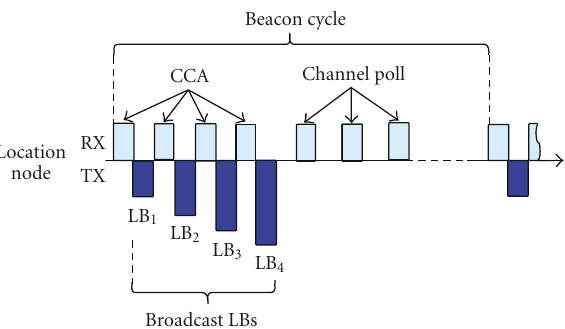
Figure 9: Location node beacon cycle using contention-MAC- unsync.